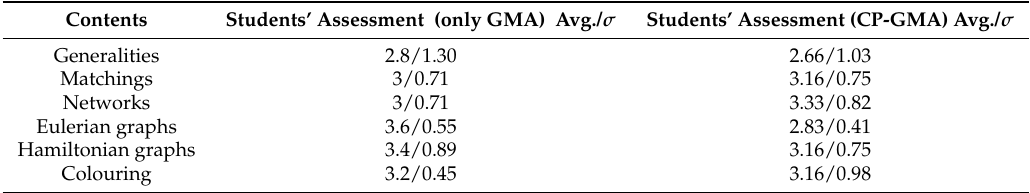
Table 2. Average and standard deviation values of the importance of GMA contents for students who took GMA only and those who studied both PC and